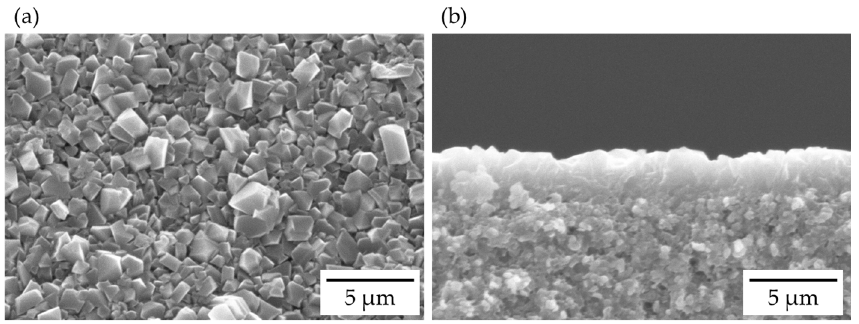
Figure 1. SEM images of ( a ) surface and ( b ) cross-section of FAU-type zeolite membranes (5 SiO 2 :1 Al 2 O 3 :7.5 Na 2 O:375 H 2 O, 18 h synthesis).